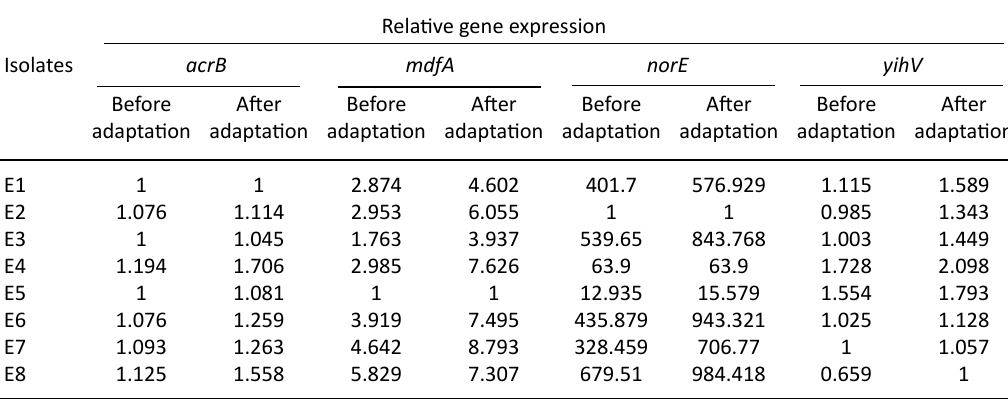
Table 5. Analysis of the relative gene expression of E. coli (n=8) after TCS adaptation Relative gene expression Isolates acrB mdfA norE